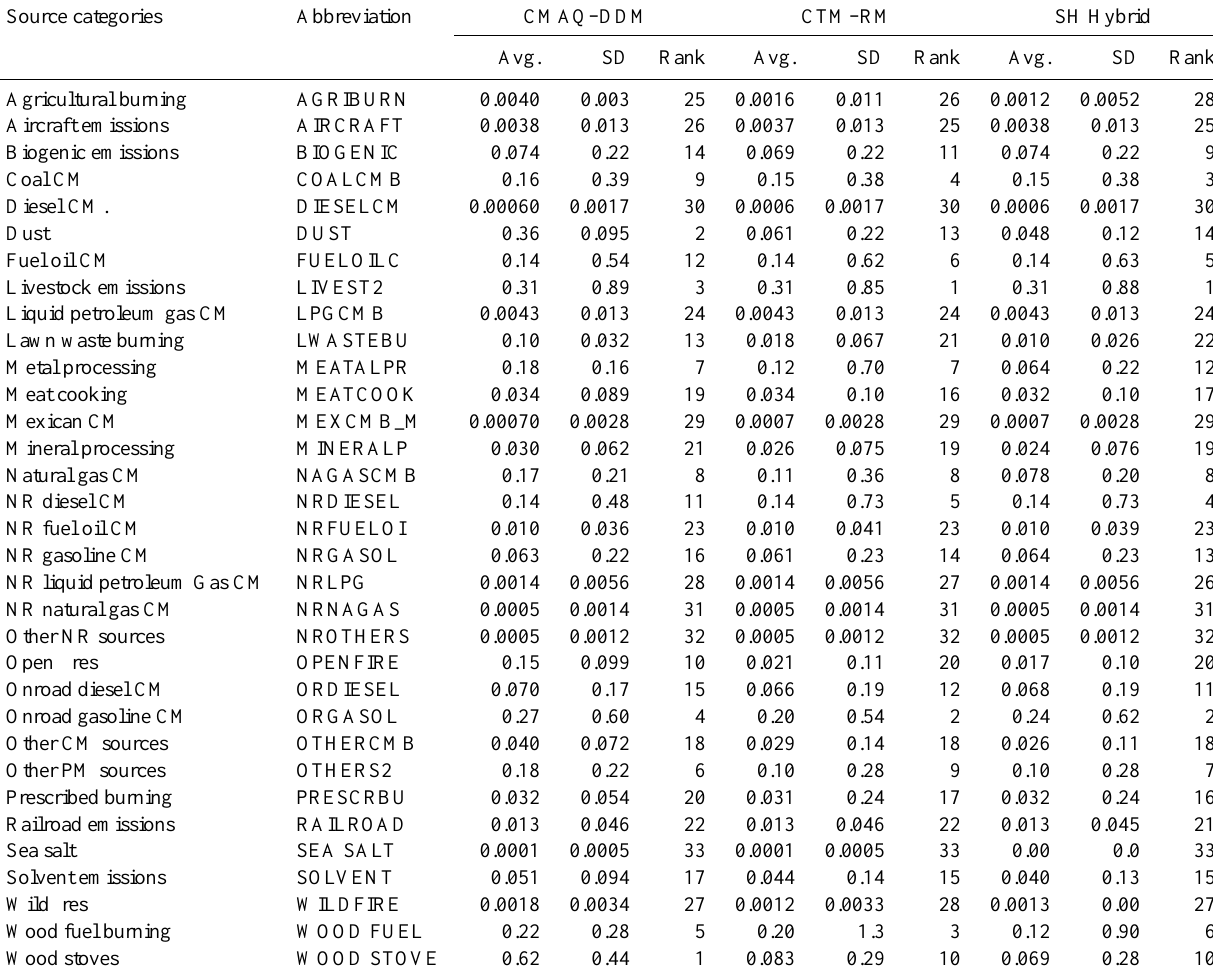
Table 1. Source category abbreviations with average CMAQ–DDM, CTM–RM, and SH (spatial hybrid) source contributions to PM 2 . 5 concentrations for withheld CSN observation locations ( N = 75 observations) for January 2004. Note: all averages and standard deviations are expressed in µgm − 3 . Average total mass of withheld observations, and corresponding CMAQ–DDM, CTM–RM, and SH estimates